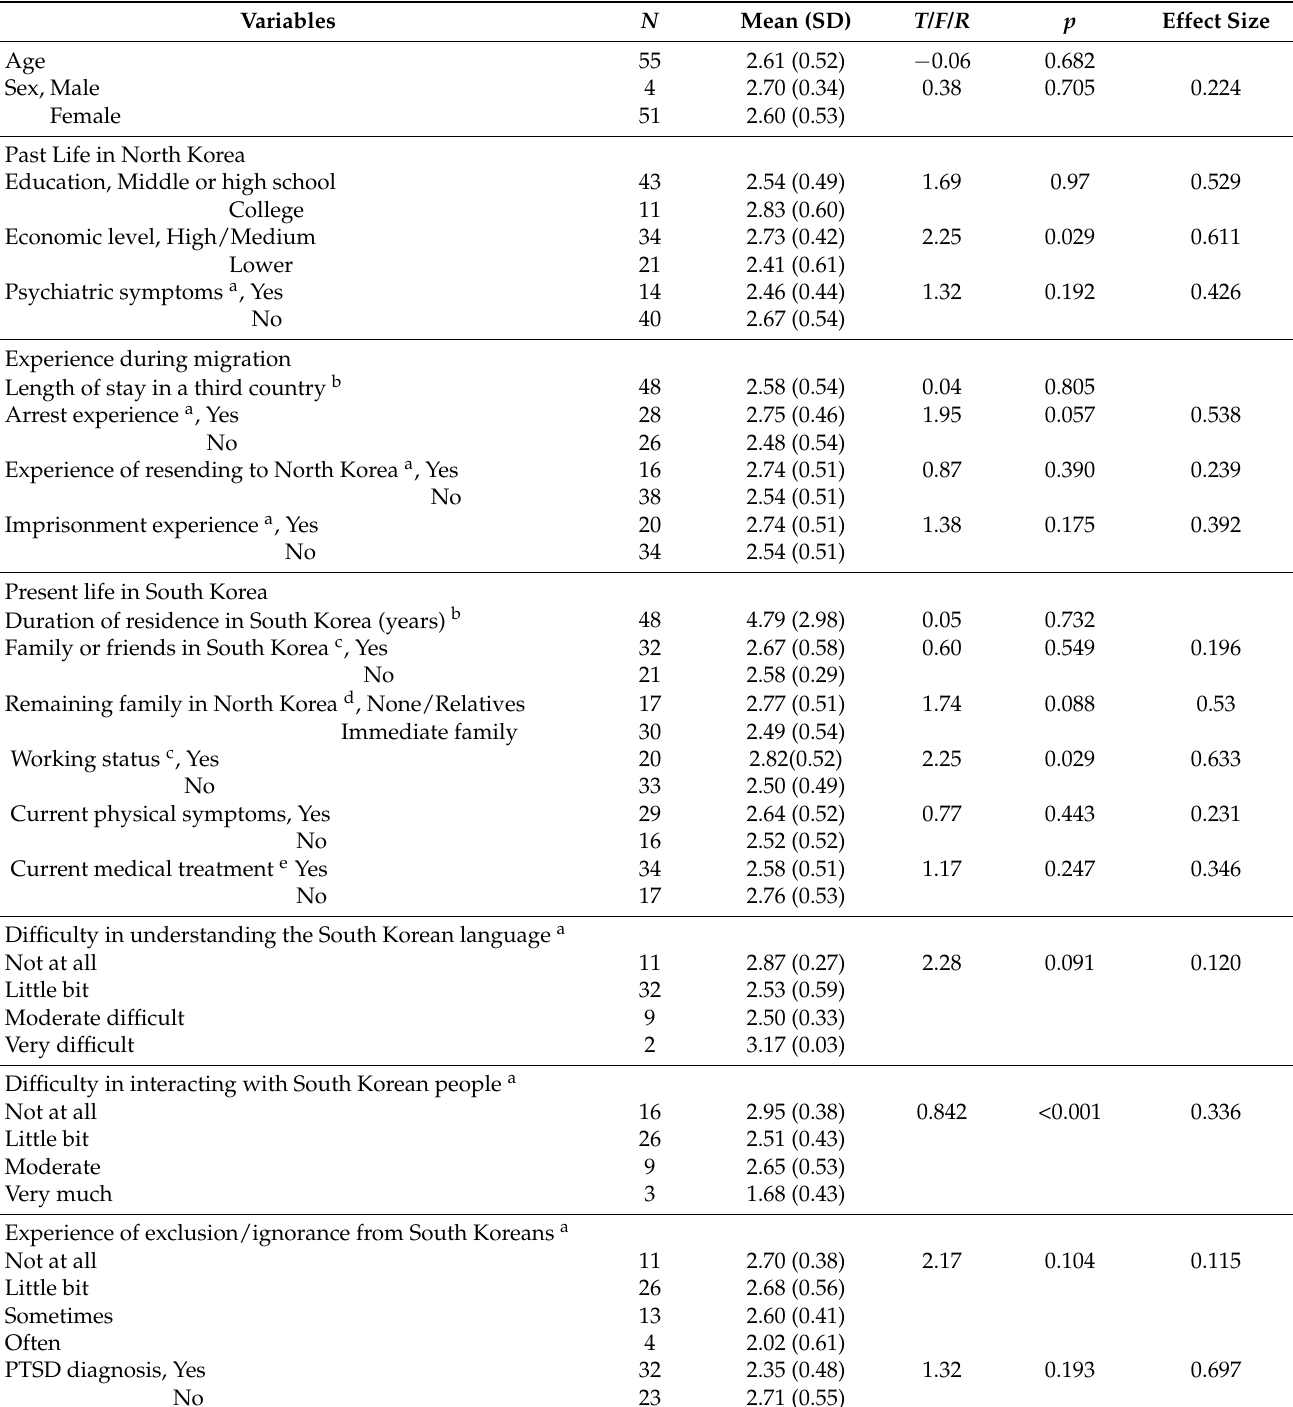
Table 1. Association of quality of life with demographics, past life history in North Korea, trauma experiences, current life condition in South Korea, and PTSD